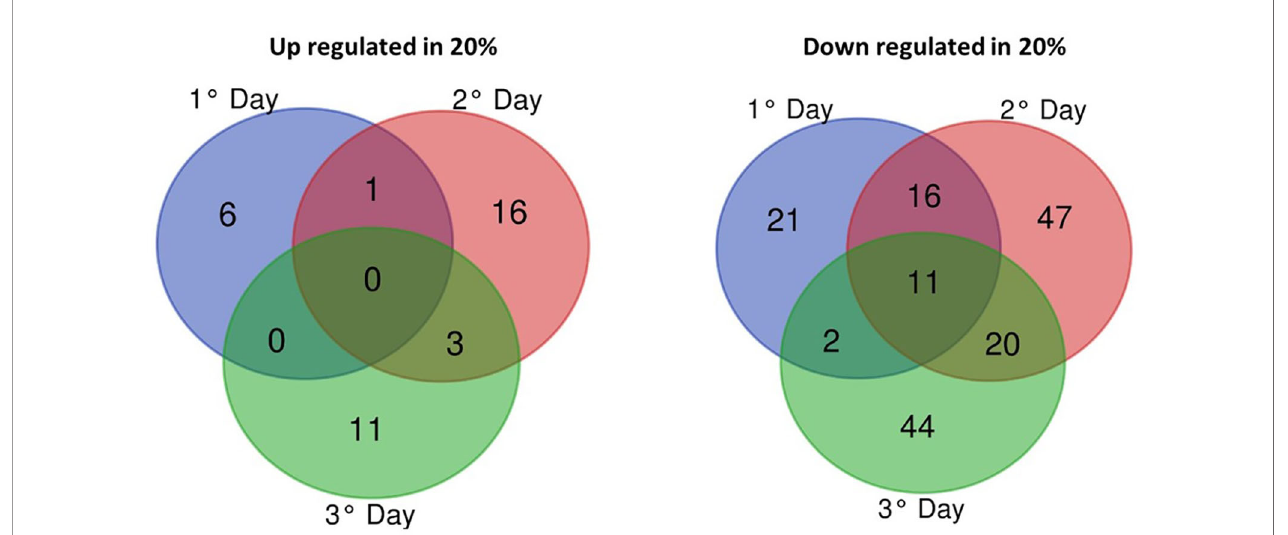
FIGURE 4 | Venn diagram of differentially-expressed genes (log2-fold > 2 (upregulated) or < -2 (downregulated) of B. bassiana grown in liquid cultures supplemented with 20% vs. 10% glucose on days 1, 2, and 3 of fermentation. The cutoff used was false-discovery rate adjusted p -value less than 0.005 (FDR p < 0.005). DEGs, statistically signi fi cantly differentially-expressed genes (see also Supplemental Table S3